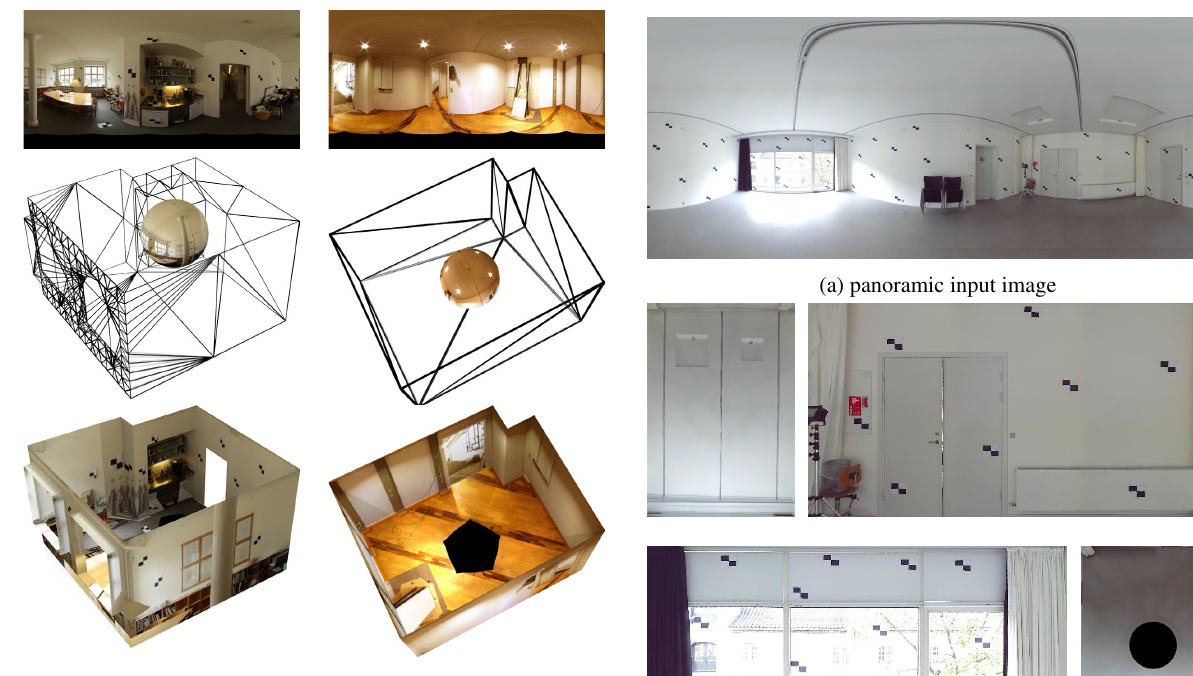
Figure 7: Two indoor scenes in different stages of reconstruction. The acquired high-resolution input panoramas (top row) were aligned to the geometry that was created from the laser range scan. The middle row shows the input geometry, and the aligned panoramic spheres. In the bottom row we see the same geome- try using the generated orthographic views as textures, the ceiling has been omitted for a better visualization.